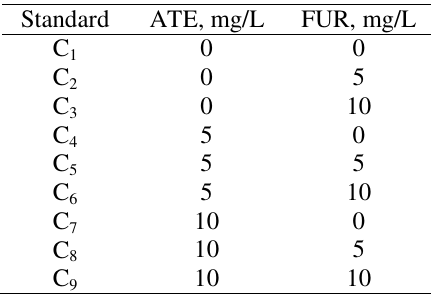
Table 1. Calibration set